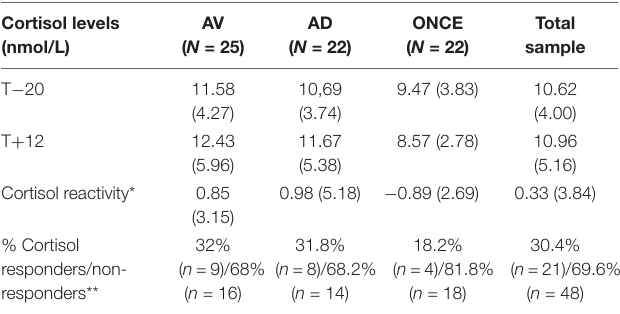
TABLE 3 | Cortisol levels (nmol/L) in the three